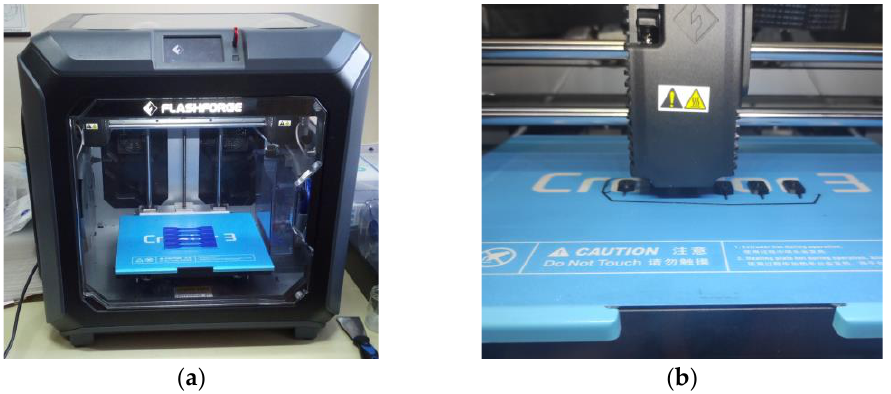
Figure 4. Additive manufacturing of the plectra: Flashforge ® Creator 3 3D printer [15] ( a ) and detail showing the rotor manufacturing process ( b ).